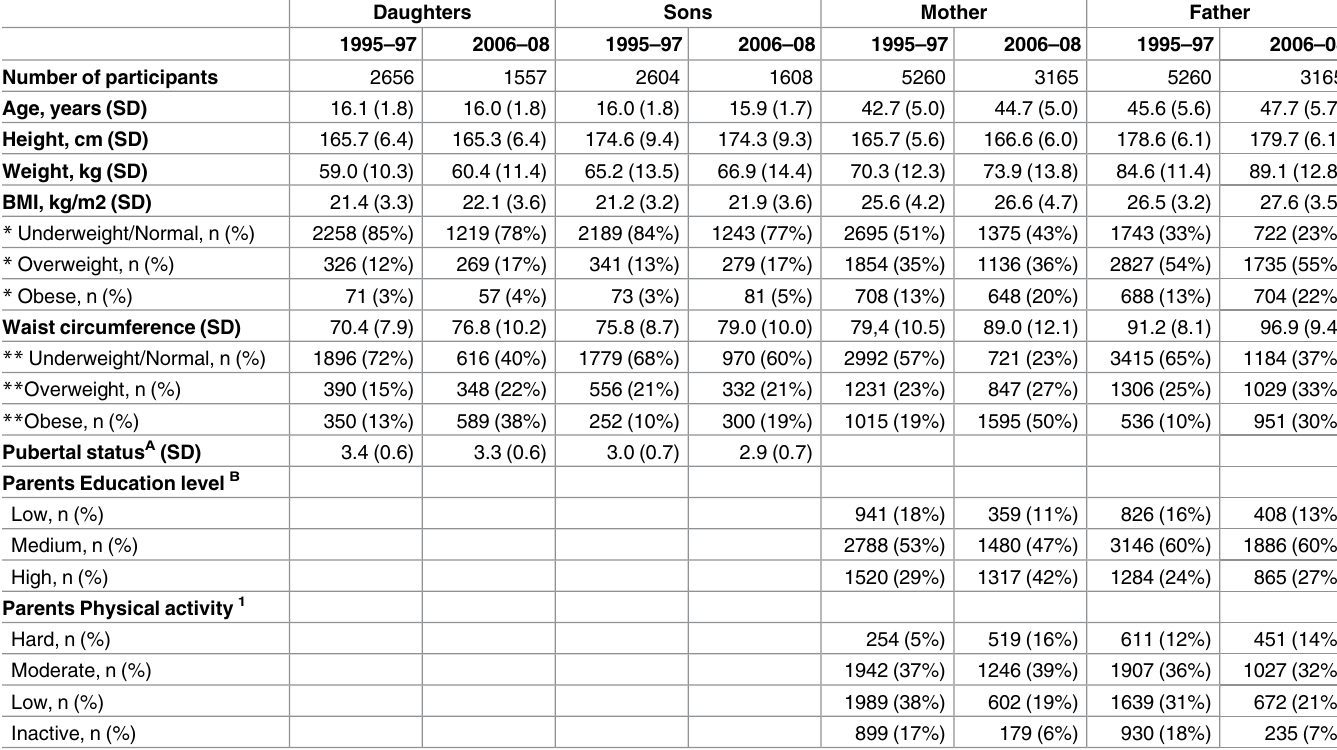
Table 1. Descriptivecharacteristic of offspring and